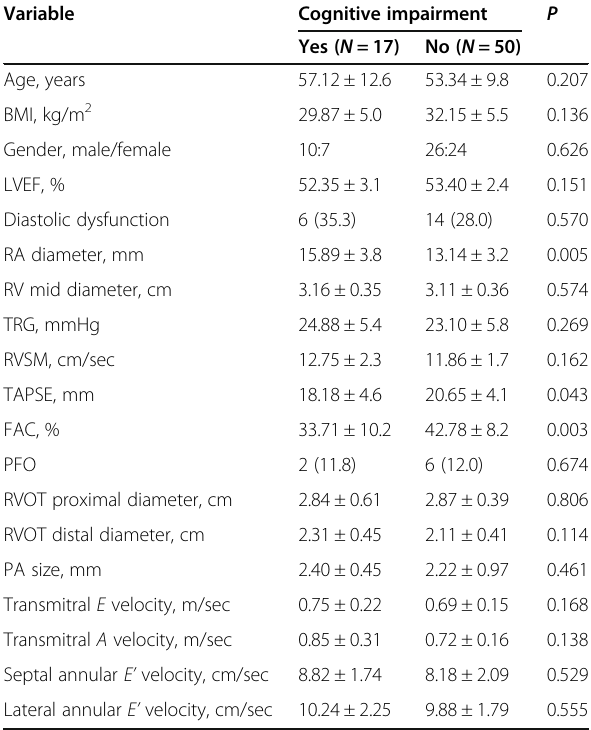
Table 2 Comparing OSA patients with and without cognitive